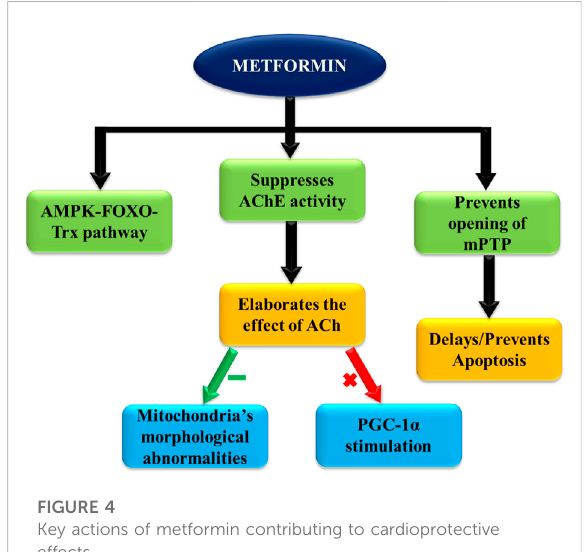
FIGURE 4 Key actions of metformin contributing to cardioprotective